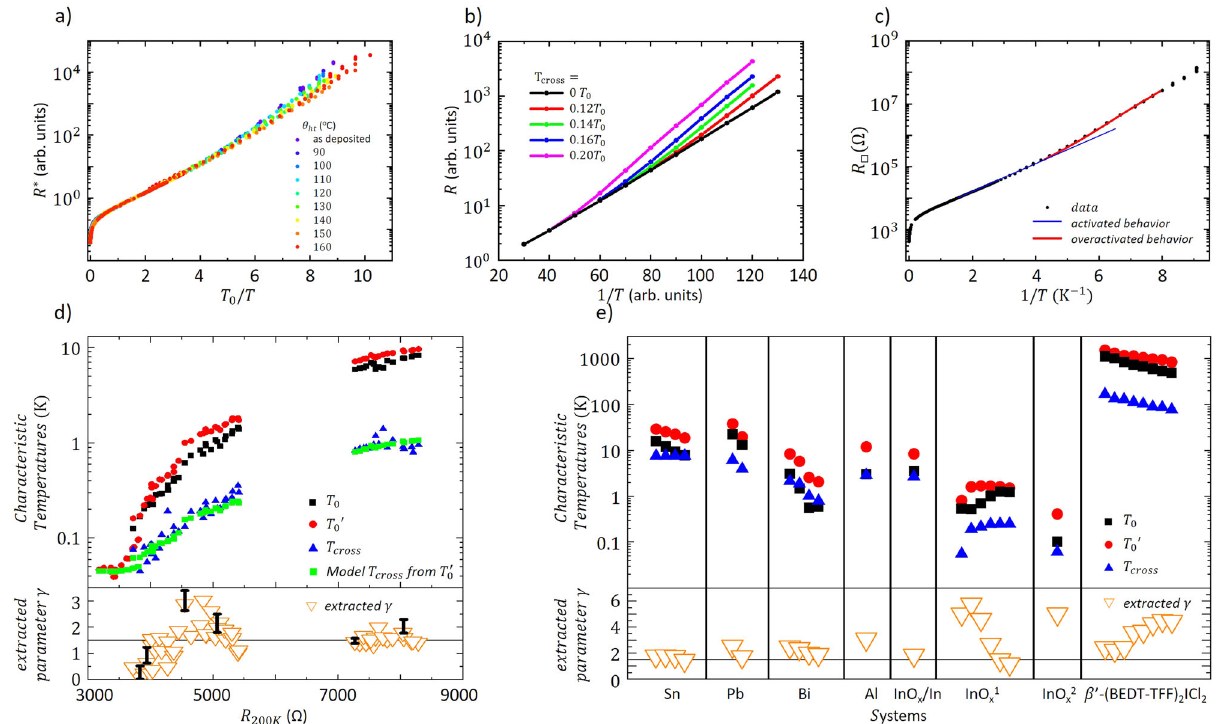
Fig. 3 Characterization of the activated and overactivated regimes. a Scaled resistance as a function of T 0 / T (with T 0 the activation temperature and T the temperature) so that the activated regime overlaps for all disorder levels (tuned by the successive heat treatments) for the 35- Å -thick 13.5% sample. The unscaled data are shown in Fig. 1e. b Simulation results for the resistance as a function of 1/ T , on a semilogarithmic scale. The black line corresponds to activated behavior, with no superconductivity, and the other curves to overactivation due to superconductivity for several values of the ratio T cross / T 0 , with T cross the crossover temperature between the activated and overactivated regimes. The overactivated regime is characterized by an activation temperature T 0 as shown Fig. 1g. c Resistance as a function of the inverse temperature, 1/ T , on a semilogarithmic scale, for the 13.5% 35- Å -thick sample (heat treatment of 110 ∘ C, black dots). The continuous blue curve is our simulation without superconductivity effects, while the red curve is with grain superconductivity for the case T cross / T 0 = 0.14. d Characteristic temperatures T 0 , T 0 and T cross for all measured samples. The bottom panel shows the value of γ ¼ 0 ð T 0 (cid:4) T Þ = T γ ¼ 1 : 5. The green squares correspond to T cross given by Eq. (10): 0 cross as given by Eq. (9). The black line then corresponds to the average exp T ’ 1 : 8 = d ½ A (cid:5) þ 0 : 105 ´ T 0 . The black error bars are typical error bars on γ at the considered disorder: far from the SIT, the error bars are typically cross 0 exp smaller than closer to the SIT, where the two activated regimes are dif fi cult to precisely de fi ne. e Characteristic temperatures T 0 , T 0 and T cross of the 0 activated regimes in several systems (re-analysis of published data). The bottom panel gives the value of γ , determined by Eq. (9). The black line ¼ 1 : 5 obtained from our results on a-NbSi. The experimental data are from ref. 15 for Sn and Pb 16 , for Bi 50 , for Al 17 , for InOx/In (Shahar, corresponds to γ exp D. Transport measurements of InOx fi lms, private communication), and ref. 23 for InOx under magnetic fi elds (respectively InOx 1 for fi elds ranging from 1 to 7 T and InOx 2 taken at 0.75 T), and ref. 22 for β 0 -(BEDT-TFF) 2 ICl 2 under pressures ranging from 0 to 1.8